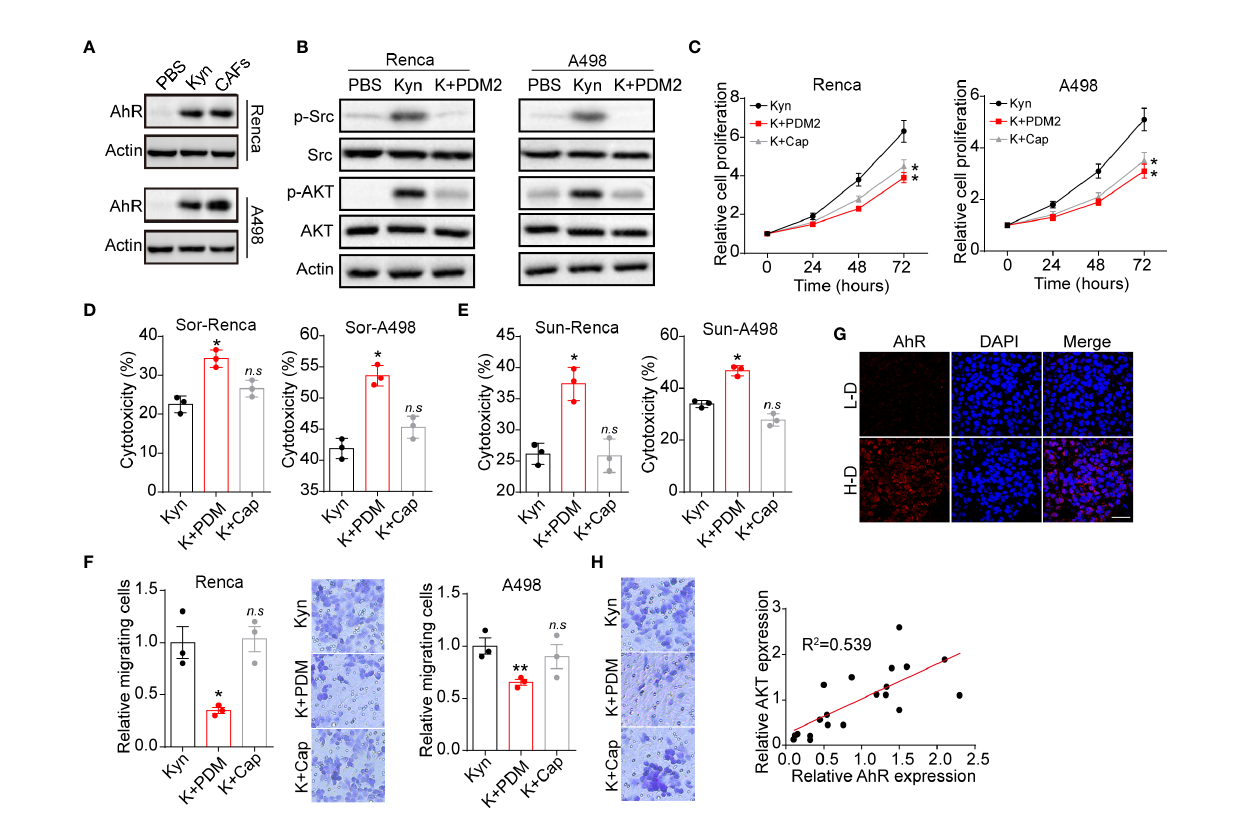
FIGURE 3 | Kyn facilitated cells proliferation by AhR/ATK signal. (A) The western blotting of AhR and b -actin in Renca/A498 treated with PBS, Kyn (0.5 m M) or CAFs co-culture. (B) The western blotting of phosphorylated Src, total Src, phosphorylated AKT, total AKT and b -actin in Renca/A498 treated with PBS, Kyn (0.5 m M) or Kyn (0.5 m M) combined with PDM2 (1 nM). (C) The relative cells proliferation of Renca/A498 treated with Kyn (0.5 m M) or Kyn (0.5 m M) combined with PDM2 (1 nM)/ Cap (10 nM). (D) The cytotoxicity of Sor to Renca/A498 treated with Kyn (0.5 m M) or Kyn (0.5 m M) combined with PDM2 (1 nM)/Cap (10 nM). (E) The cytotoxicity of Sun to Renca/A498 treated with Kyn (0.5 m M) or Kyn (0.5 m M) combined with PDM2 (1 nM)/Cap (10 nM). (F) The relative migrating cells numbers and representative images of Renca/A498 treated with Kyn (0.5 m M) or Kyn (0.5 m M) combined with PDM2 (1 nM)/Cap (10 nM). (G) Immuno fl uorescence staining of AhR in tumor tissues from high degree (H-D) and low degree (L-D) malignant renal patients. The scale bar is 50 m m. (H) The correlation analysis of AhR and phosphorylated AKT in tumor tissues from renal patients. Mean ± SEM, n.s, no signi fi cant difference, *p < 0.05, **p <